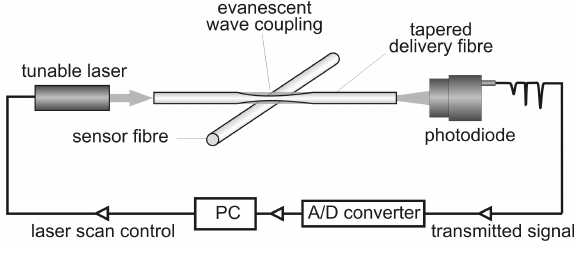
Figure 1. Schematic of the experimental setup for optical fibre whispering gallery mode spectroscopy. Light from a tunable laser is coupled into a tapered optical ‘delivery’ fibre in contact with a ‘sensor’ fibre. As the laser wavelength is scanned, light coupled into whispering gallery mode resonances in the sensor fibre leads to periodic dips in the optical signal transmitted through the delivery